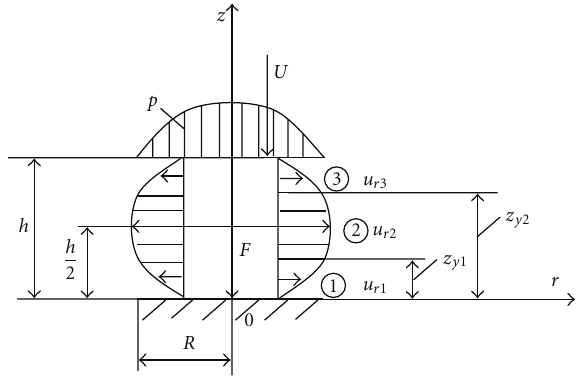
Figure 2: Squeeze model of MR fluid between two parallel